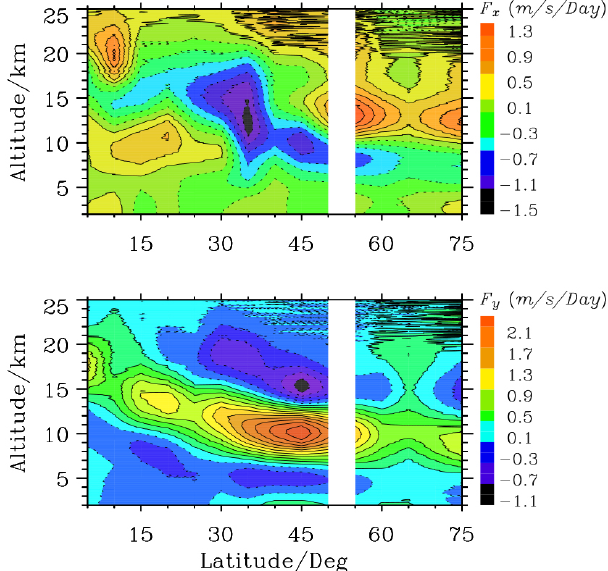
Figure 12. Latitudinal and vertical variations of averaged high- frequency-gravity-wave-induced zonal (upper panel) and merid- ional (lower panel) forces (in ms − 1 day − 1 ). The blanks denote no